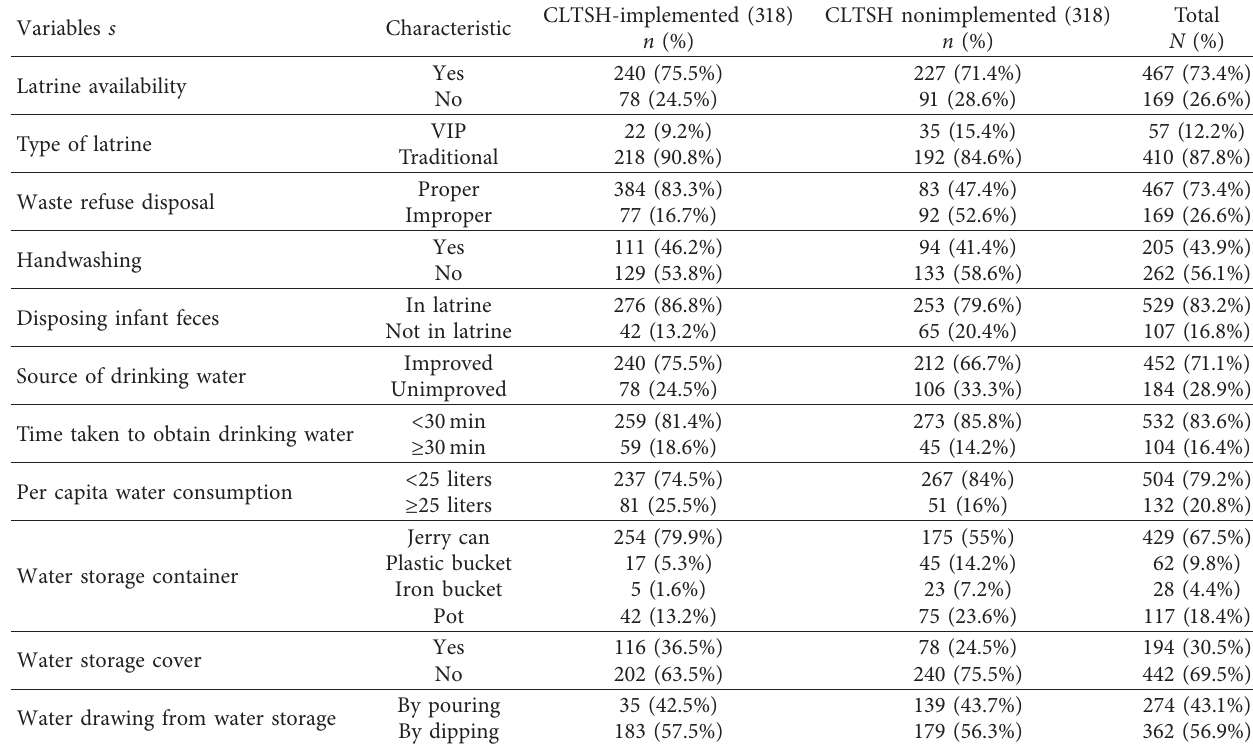
Table 3: Environmental characteristics in selected CLTSH implemented and nonimplemented woreda in Gamo Gofa Zone, 2018. Variables s